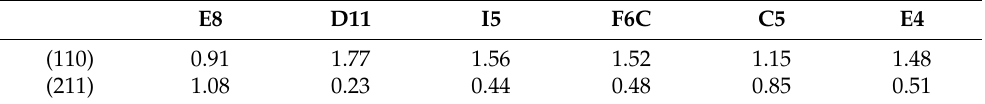
Table 4. Texture coefficient of (110) and (211) planes.